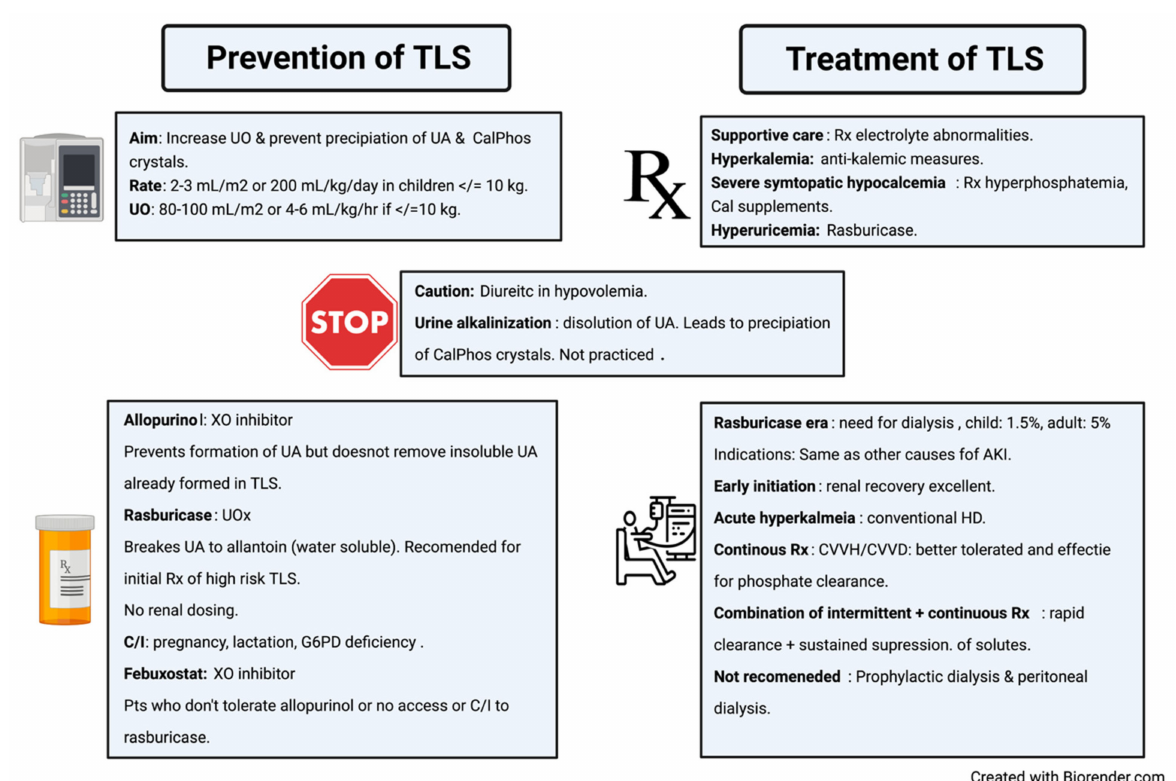
Figure 4. Infographic that summarizes prevention and treatment of tumor lysis syndrome. TLS = tumor lysis syndrome, UO = urine output, CalPhos = calcium phosphate, UA = uric acid, XO = xanthine oxidase, Rx = treatment, C/I = contraindication, G6PD = glucose 6 phosphate dehydrogenase, AKI = acute kidney injury, HD = hemodialysis, CVVH/HD = continuous veno venous